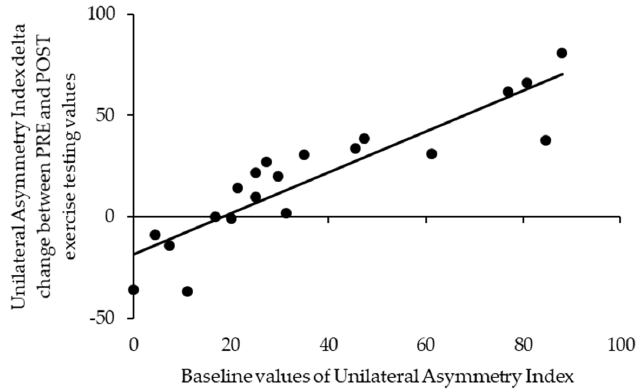
Figure 3. Delta change between before (PRE) and after (POST) the exercise testing values for Unilateral Asymmetry Index (R 2 = 0.79, p < 0.0001).